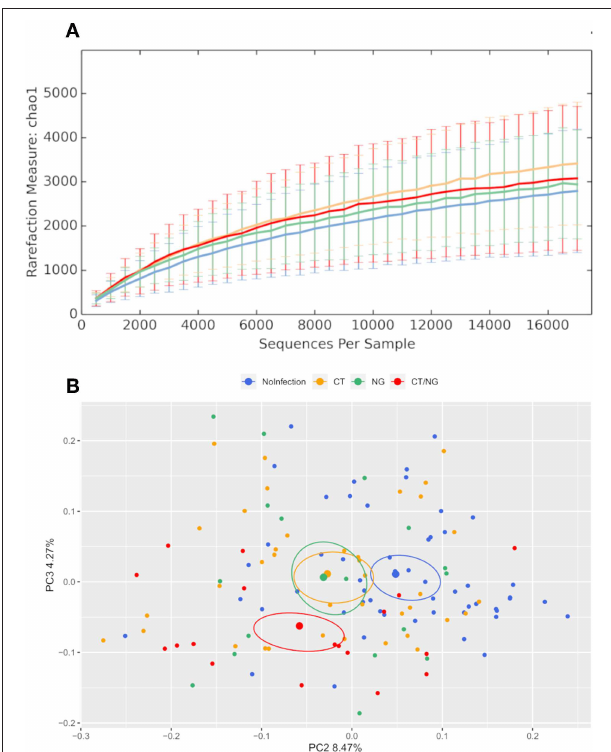
FIGURE 1 | Structure of the rectal microbiota. Microbial composition from rectal swabs of the different analyzed groups: control subjects (no infection, blue), patients with C. trachomatis (CT, yellow) infection, patients with N. gonorrhoeae infection (NG, green), and subjects positive contemporary for both pathogens (CT/NG, red). (A) Alpha-diversity rarefaction curves of Chao1 index. (B) Principal Coordinates Analysis (PCoA) plot based on unweighted Unifrac distance (beta-diversity). Each point corresponds to a sample. For each experimental group, the SEM-based confidence ellipse and the average value centroid are depicted. The second and third principal coordinates are